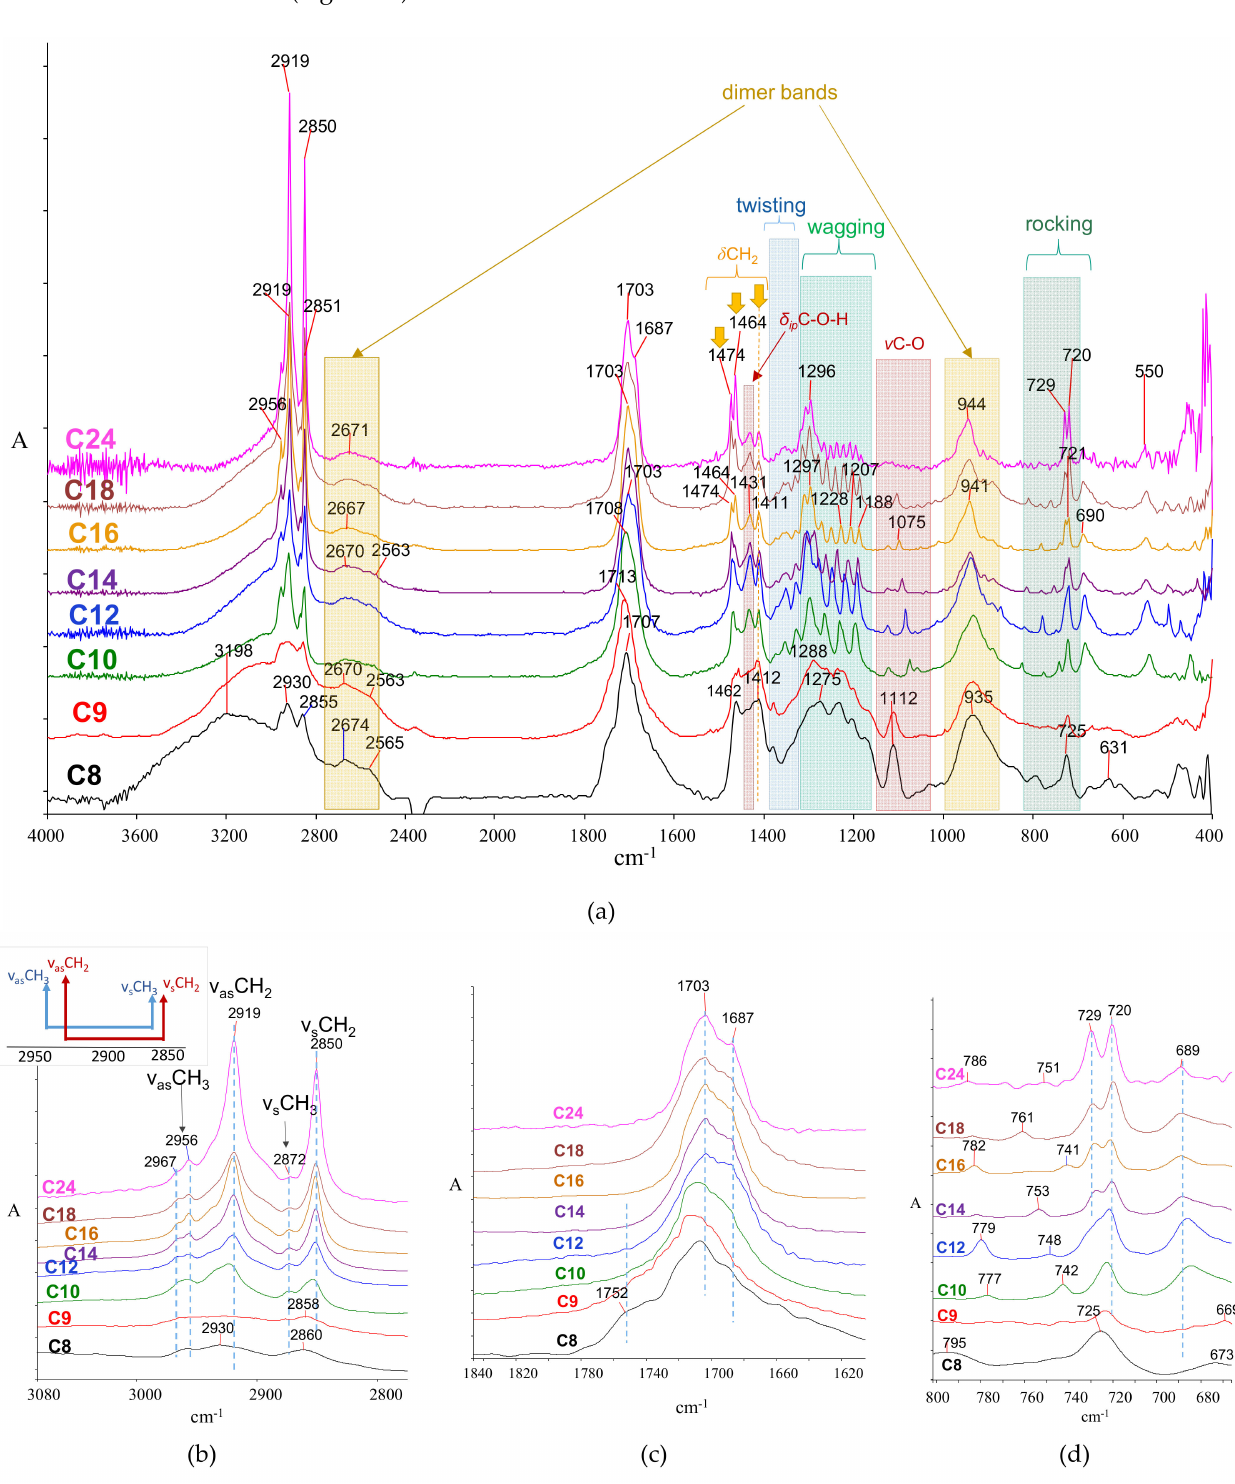
Figure 2. Infrared spectra of fatty acids. ( a ) Full spectra with shaded areas highlighting characteristic features; ( b ) C-H stretching; ( c ) carbonyl stretching; and ( d ) rocking vibrations. In all spectra: (i) C8, octanoic; (ii) C9, nonanoic; (iii) C10, decanoic; (iv) C12, dodecanoic; (v) C14, tetradecanoic; (vi) C16, hexadecanoic; (vii) C18, octadecanoic; (viii) C24, tetracosanoic. The negative peak at ~2380 cm − 1 for C8 corresponds to carbon dioxide as a result of improper background